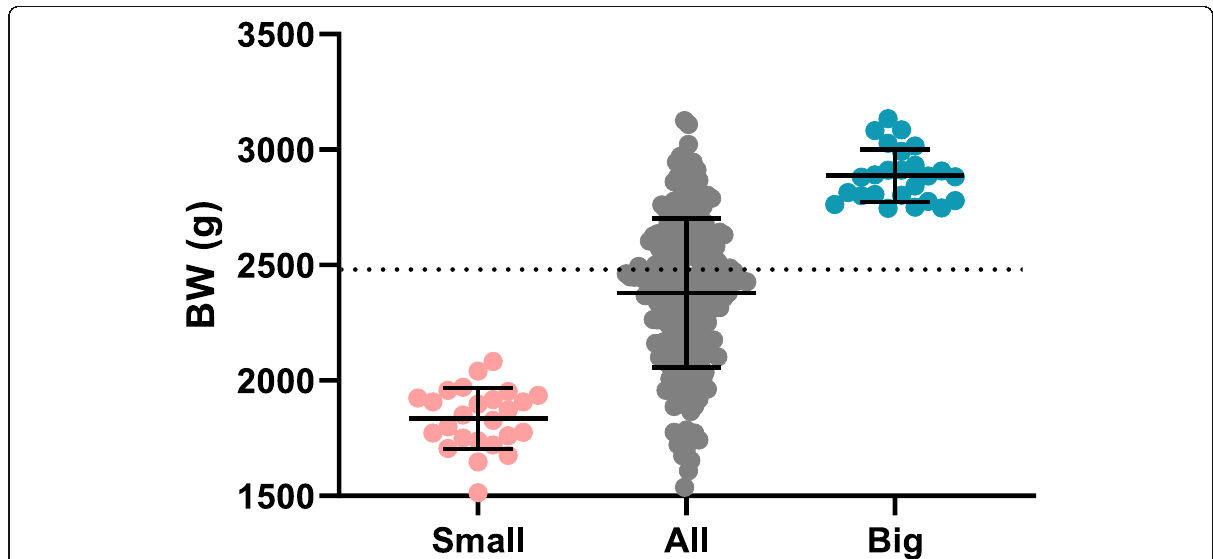
Fig. 1 BW after 37 days of rearing for the flock of 211 birds and for the 25 lightest and 25 heaviest birds selected for microbiome analysis. Dotted line indicates expected BW according to breeder ’ s performance objectives, solid lines indicate mean BW with SD. BW = body